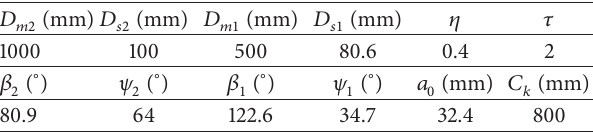
Table 1: Main parameters of the elliptical beam